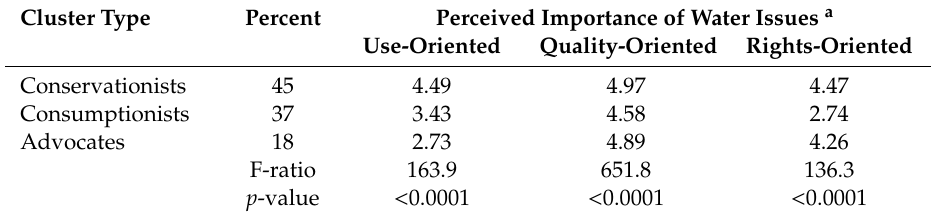
Table 2. Resident cluster types based on importance of water issues in Oklahoma, percentage of cluster residents by cluster type, and mean perceived importance for components by cluster